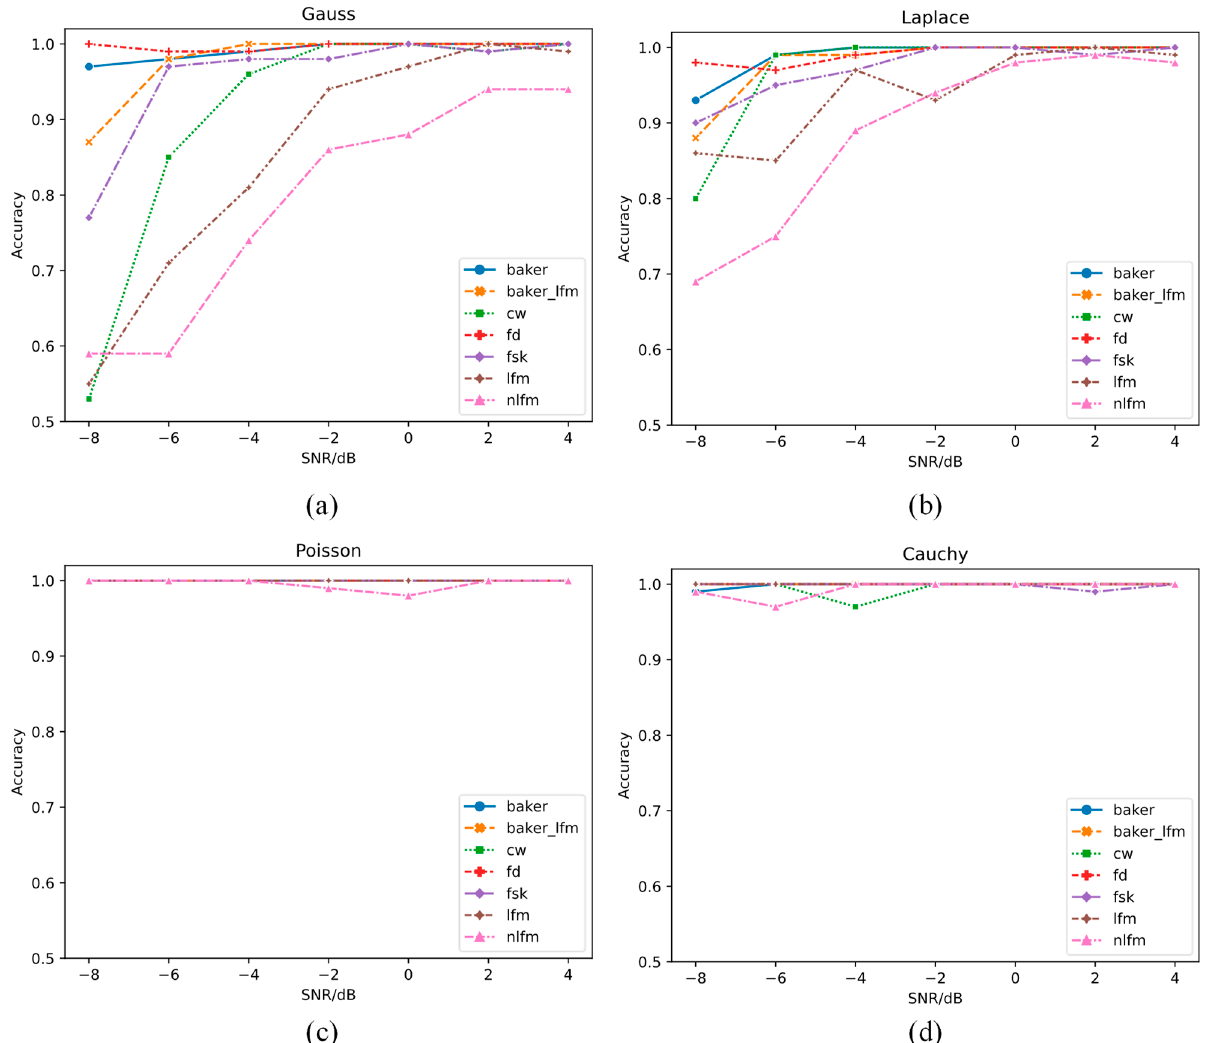
Figure 6. Recognition rate under ( a ) Gaussian, ( b ) Laplacian, ( c ) Poisson, and ( d ) Cauchy noise conditions.